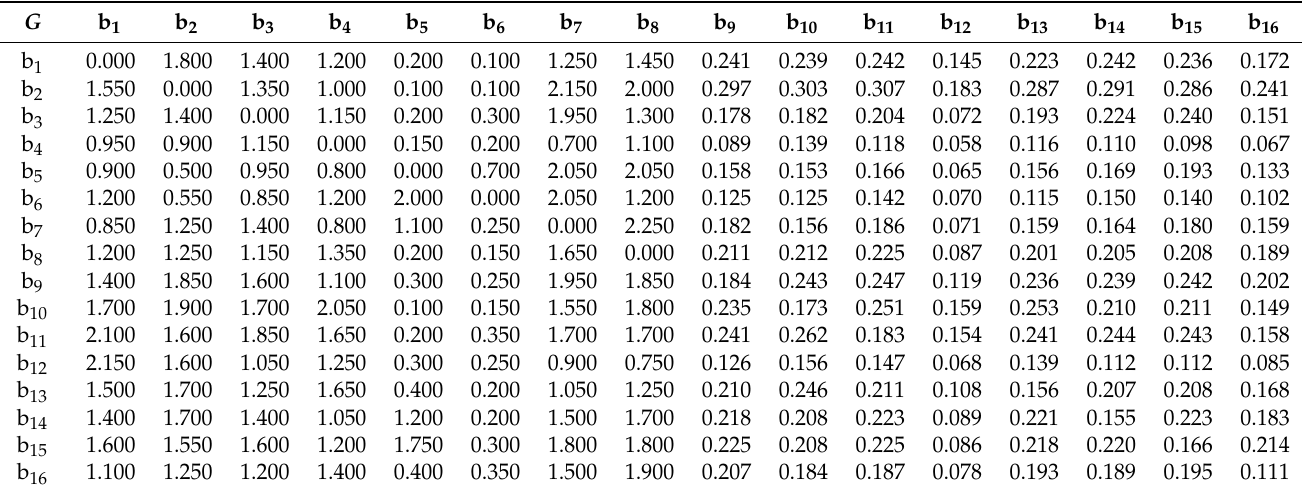
Table 5. Direct influence matrix G (16 ×